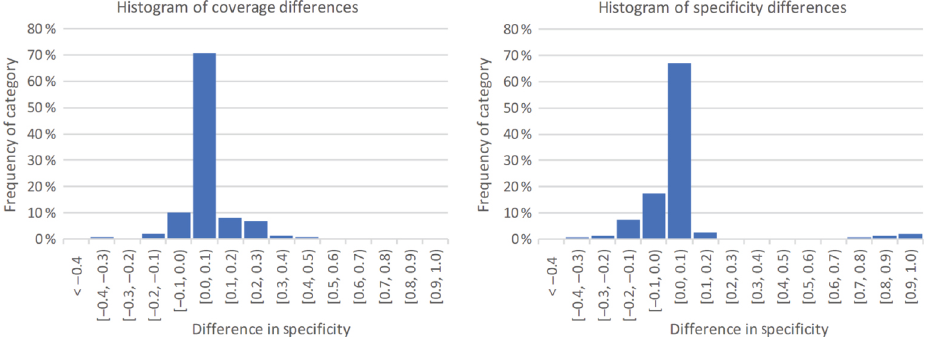
Figure 4: Plot showing the differences between coverage and specificity values for the resources in both versions of the dataset. On the left, we see the overall evolution of the two measures, and on the right a detail of the same plot showing a magnified region. The detail shows 143 of the 161 resources, or about 88 %.